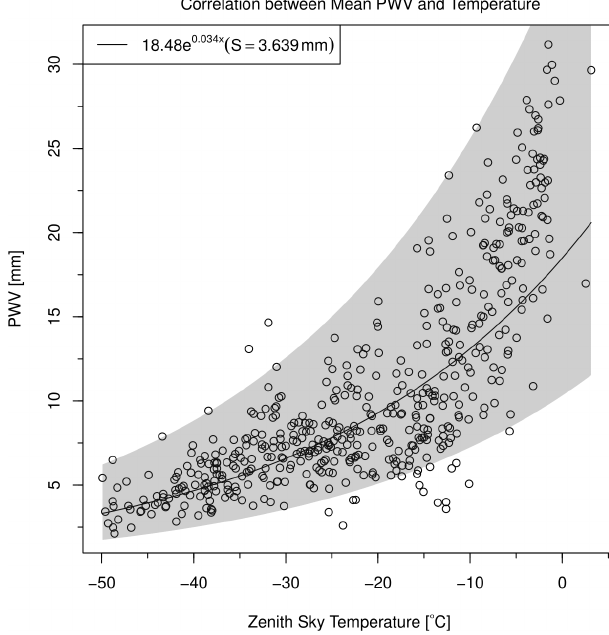
Figure 5. Analytical results of the relationship between precipitable water vapor and zenith clear-sky temperature. Individual days are plotted with white circles. The solid black curve indicates an aver- age best-fit exponential relationship based on 5000 iterations; this includes the 95% prediction interval of the data (shaded region). The fit parameters and residual standard deviation, S , are indicated in the